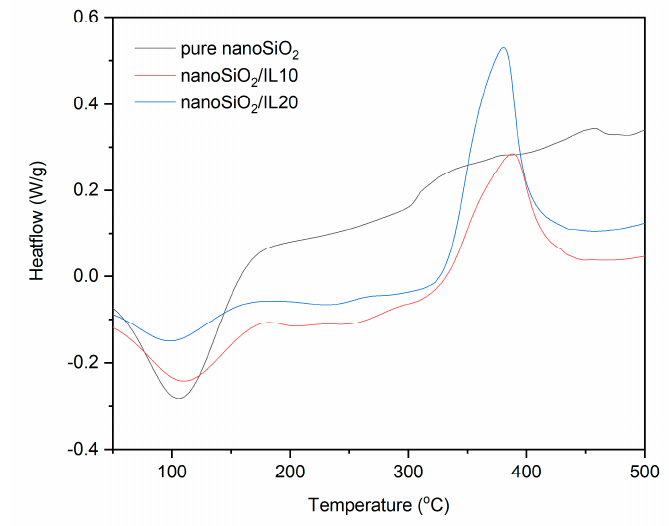
Figure 8. DSC curves for pure and DmiBr-modified nanoSiO 2 (exoˆ).